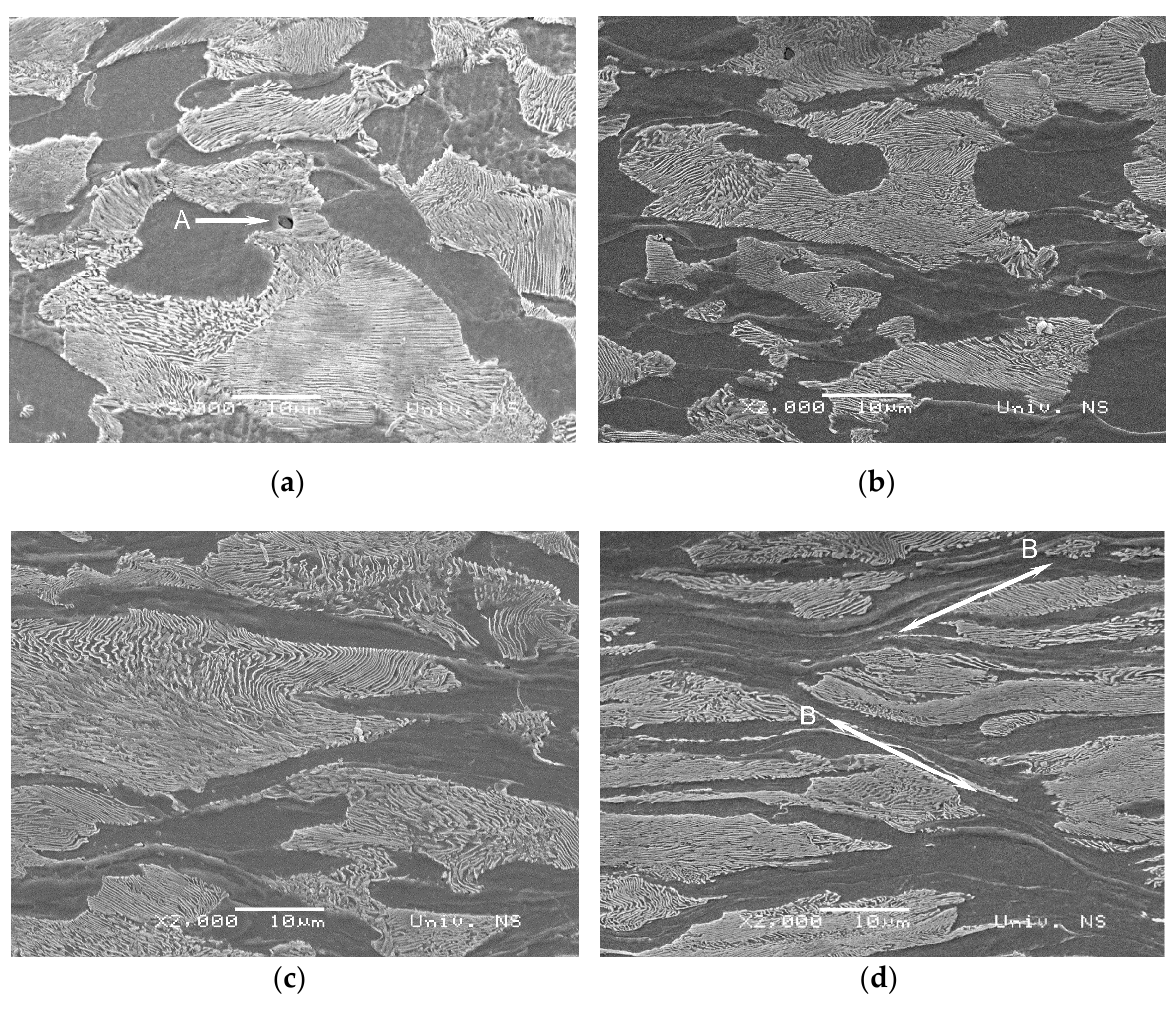
Figure 5. The SEM images of microstructure for different strains): ( a ) ε z1 = 0.38; ( b ) ε z 2 = 0.75; ( c ) ε z 3 = 1.10; ( d ) ε z 4 = 1.59; (×2000 magnification).